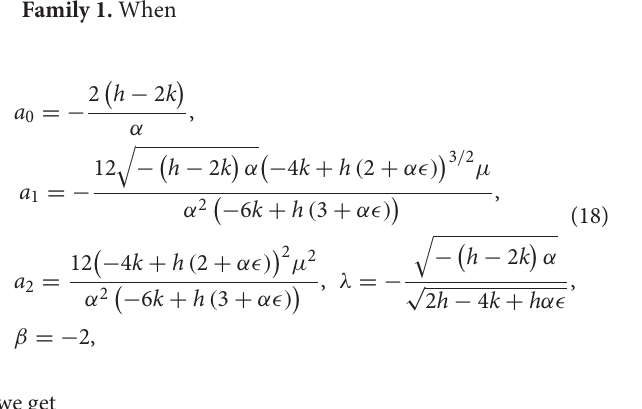
Frontiers in Physics |